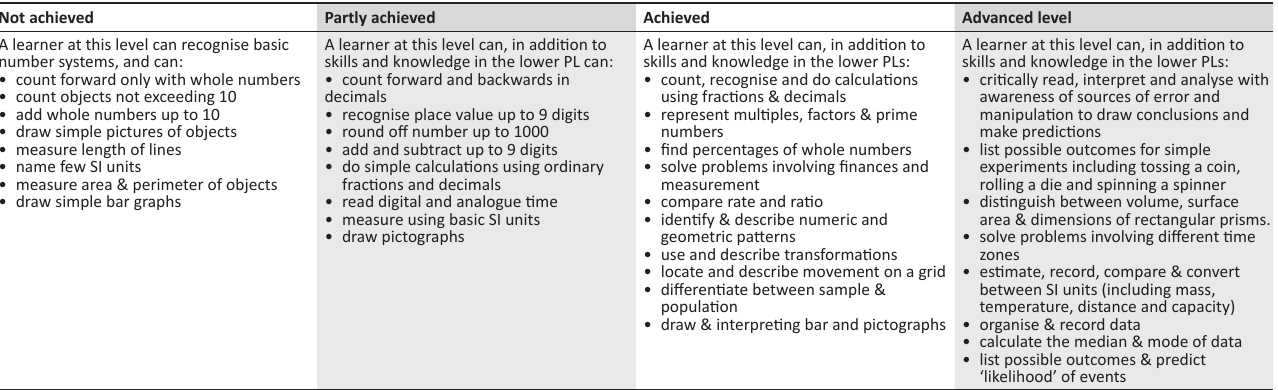
Table 2-A1 lists the specific mathematics knowledge and skills that learners functioning at each performance level are expected to demonstrate. TABLE 2-A1: Mathematics knowledge and skills at each performance